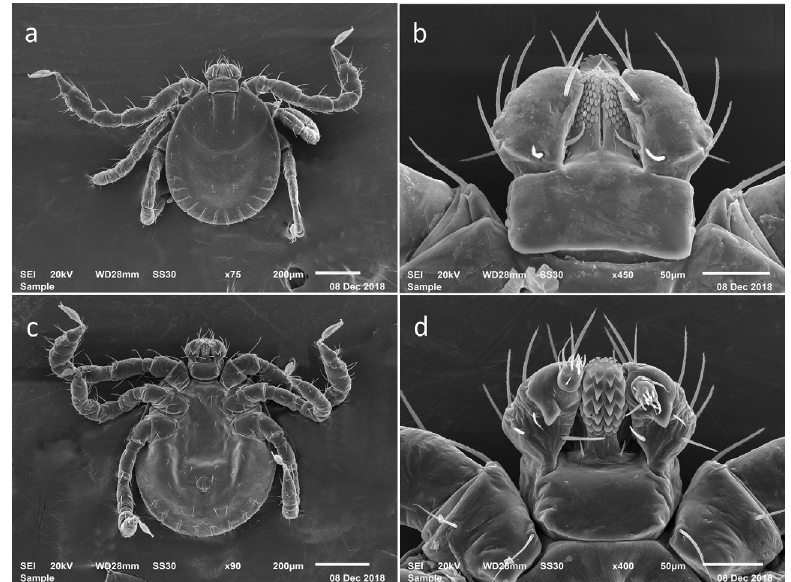
Figure 4. SEM photos of larval H. longicornis from a colony started with specimens from Queensland, Aus- tralia (Accession # RML58949). a dorsal full body b dorsal capitulum c ventral full body d ventral